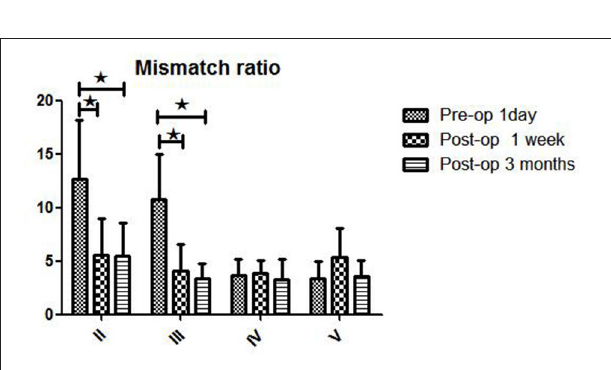
FIGURE 2 | WB-CTP showing hemodynamic characteristics in DT > 3s in ischemic MMD patients of different Suzuki stages (II–V stage) at different time points, ⋆ P < 0.05.